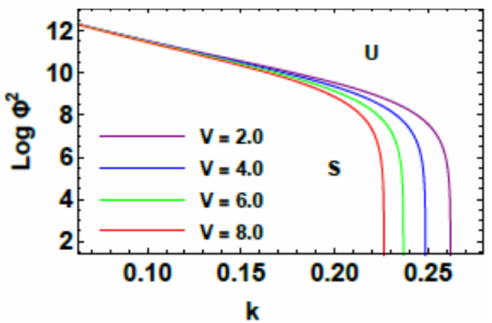
Figure 11. Plots of the stability bound for V for different values the parameter k versus Log Φ 2 .